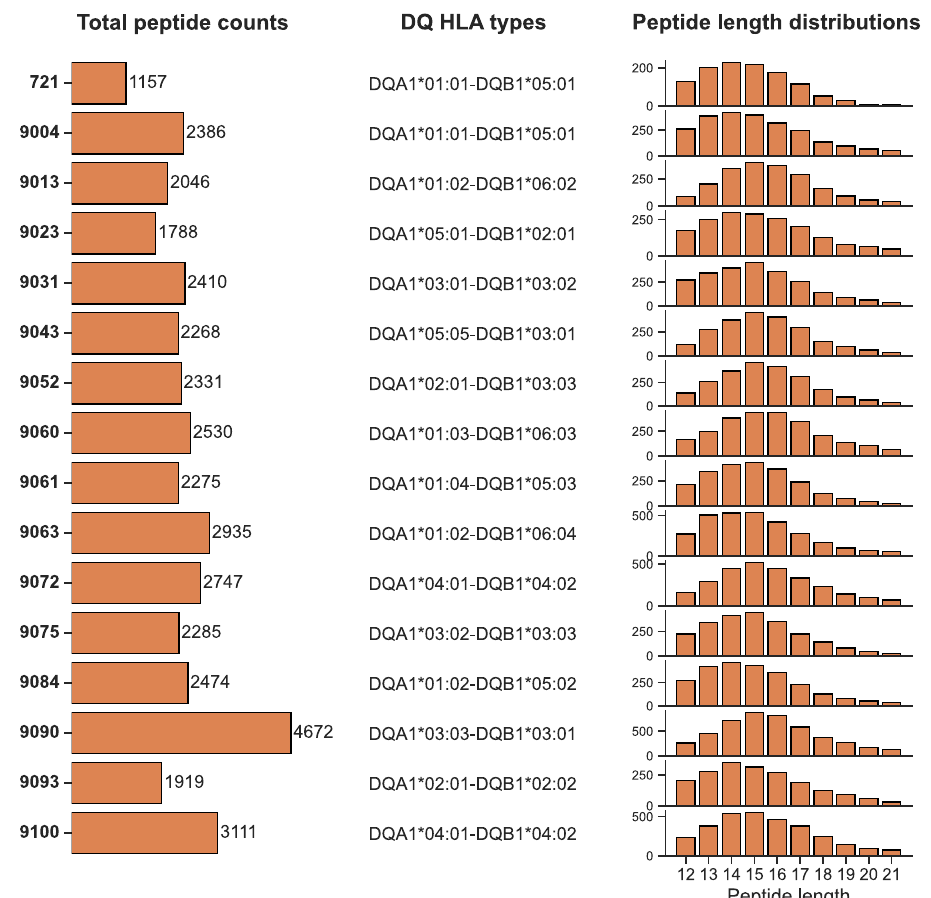
Fig. 1 Overview of the novel immunopeptidomics data. Each row corresponds to a dataset from a given DQ-homozygous cell line. Left panel: Bar plot of overall peptide counts. The numbers on the left correspond to the cell line IDs. Middle panel: DQ HLA types of the cell lines. Right panel: Peptide length